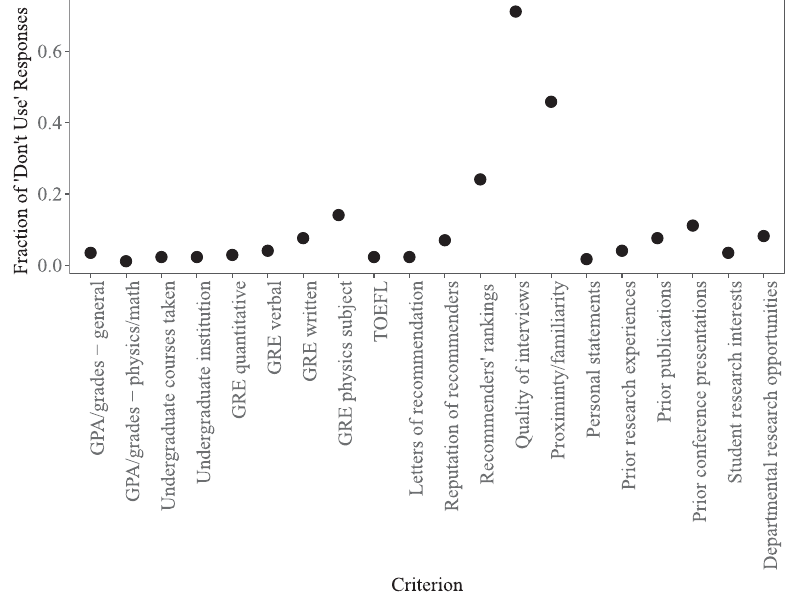
FIG. 2. Proportion of respondents indicating they “ Don ’ t Use ” specific admissions criteria.